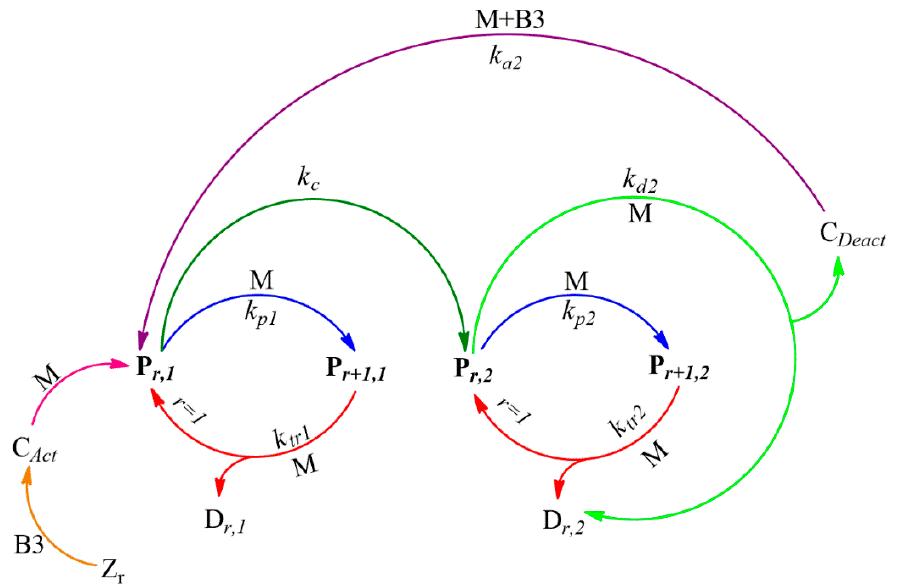
Figure 2. Proposed kinetic mechanism for the ethylene polymerization by zirconocene catalysts and organoboron activators. Kinetic parameters: k pi denotes the propagation rate constant for active polymer type i ; k tri denotes the transfer chain to monomer rate constant for active polymer type i ; k c is the transition rate constant form P r, 1 to P r, 2 ; k d 2 is the spontaneous deactivation rate constant of active polymer type 2; and k a2 is the re-activation of C Deact species, via the reaction with M and B3 . The description of each species appears in the text.